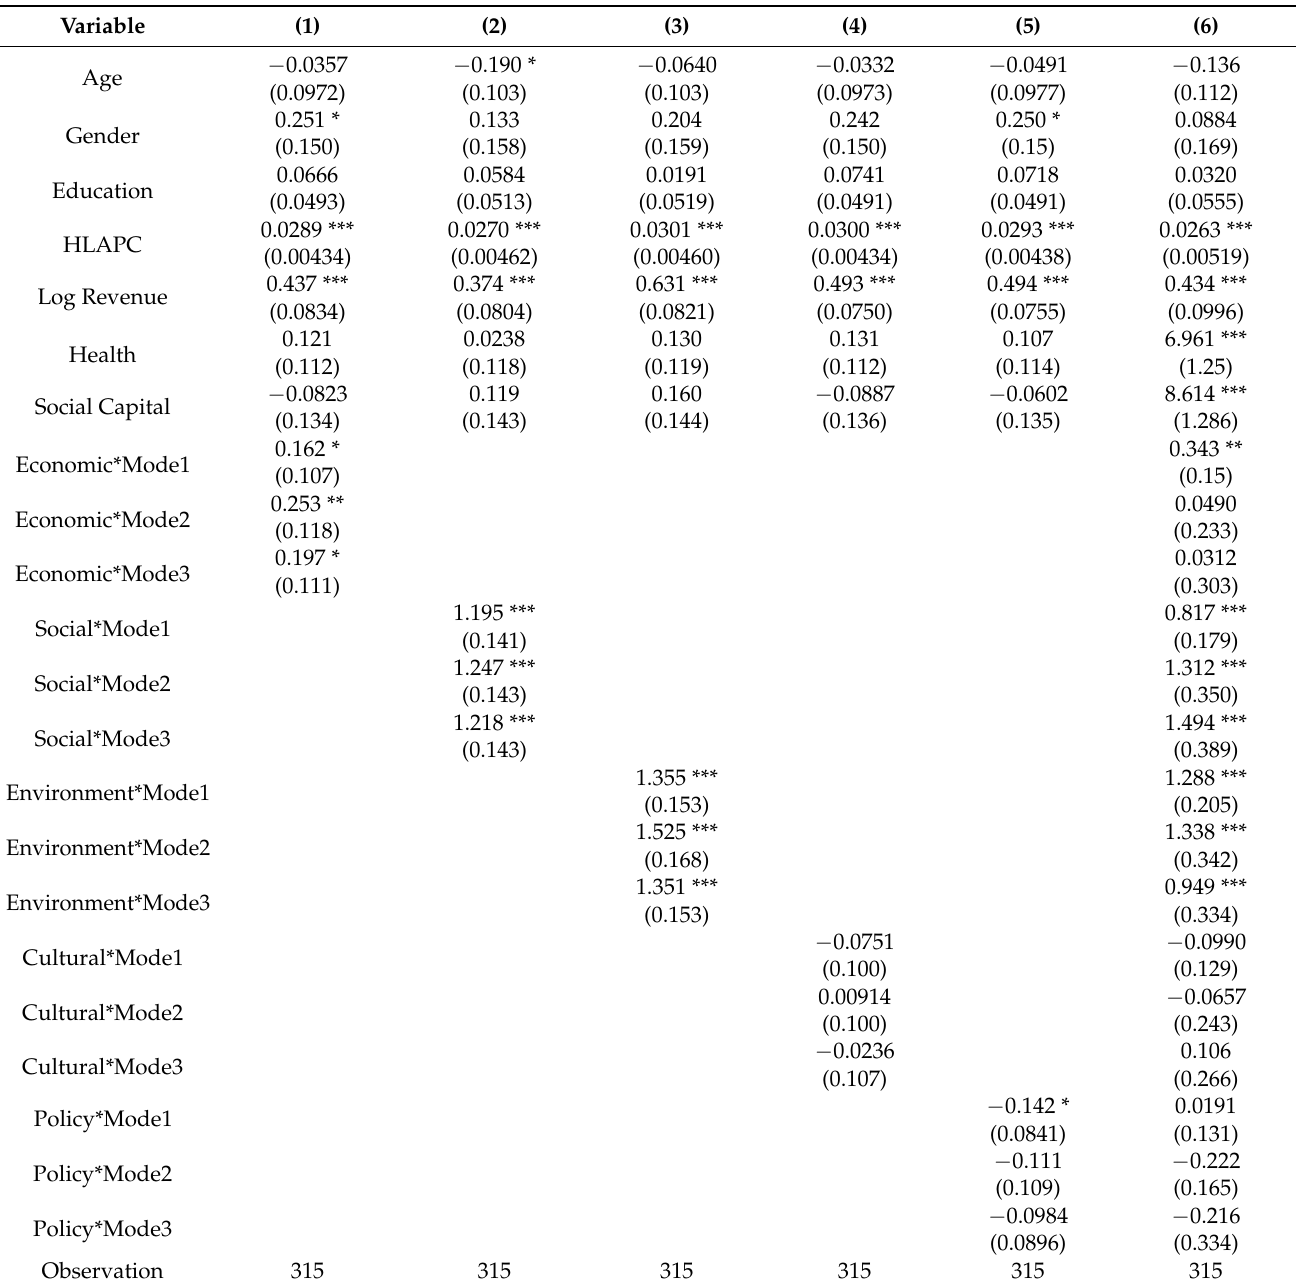
Table 6. Index system for variable